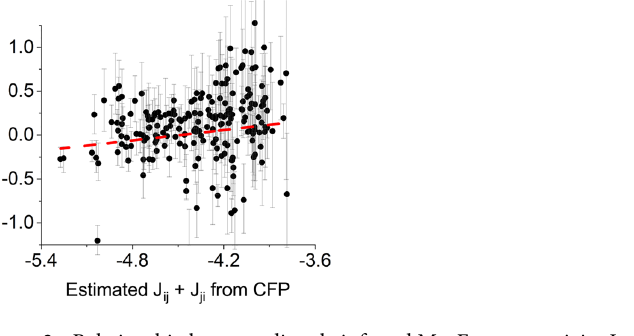
Figure 3. Relationship between directly inferred MaxEnt connectivity J and MaxEnt connectivity estimated from CFP parameters ˆ J . Both models were applied to spontaneous activity of n=20 cultures. x -axis shows the predicted ˆ J ij + ˆ J ji from Eq. (6), while the y -axis shows the directly inferred estimates J ij + J ji of those connections that were found by CFP analysis (R= 0.44). Red dashed line shows fitted linear trend. Error bars indicate 32 – 68%